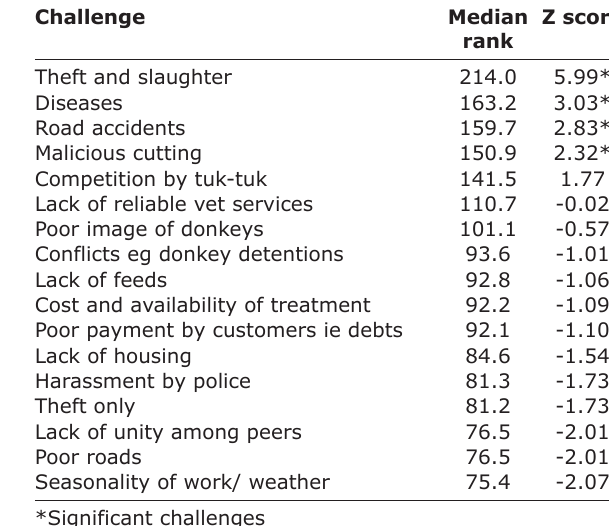
Table-2: Challenges experience by working donkeys according to smallholder farmers in Kirinyaga